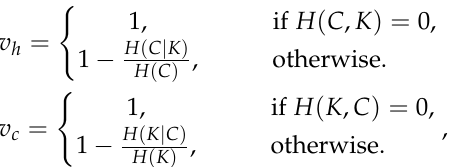
Table 3. Comparison of the proposed GANDA with BAGAN in terms of V-Score.